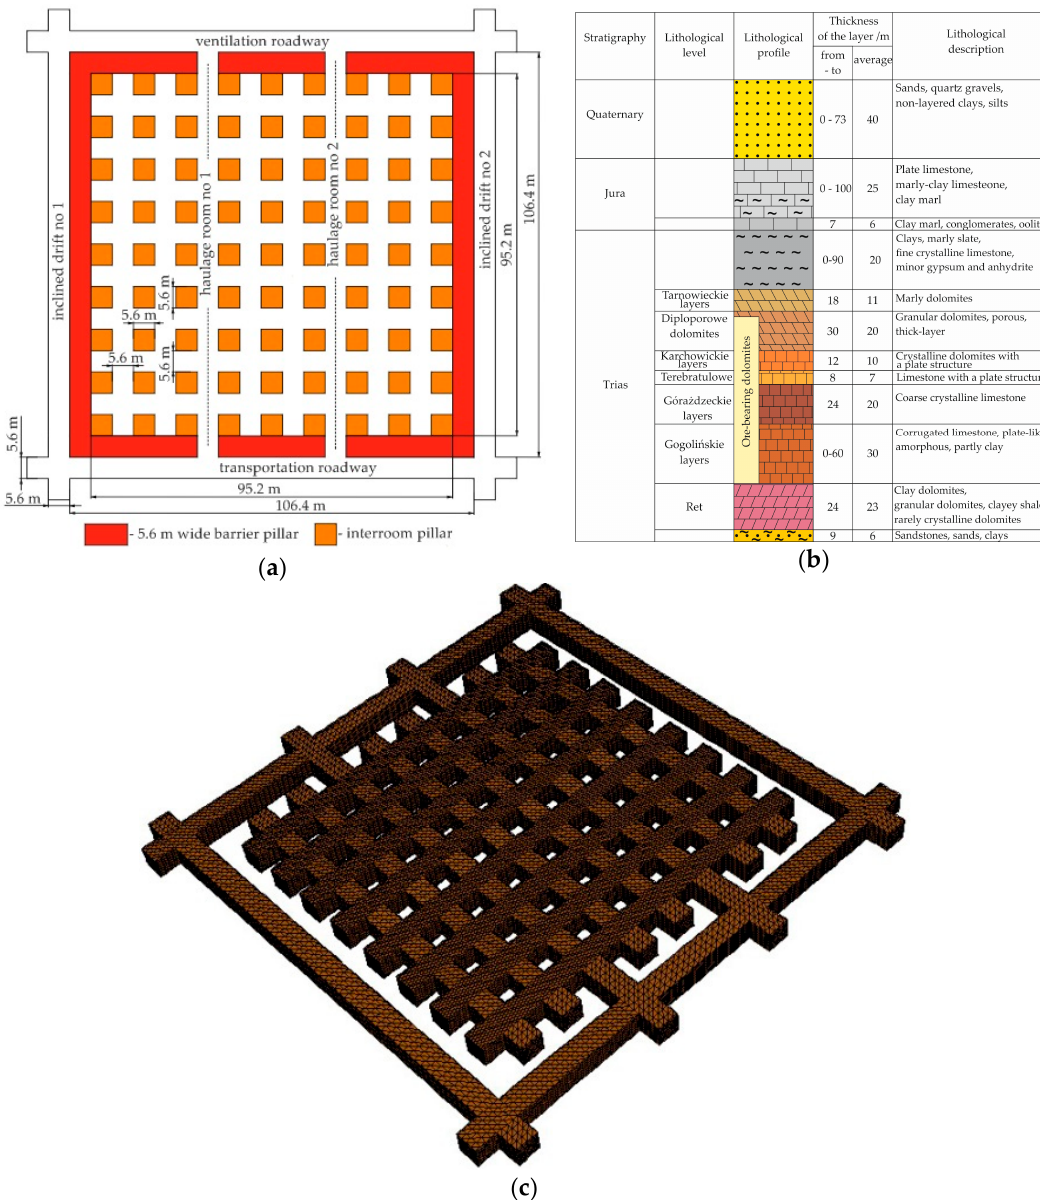
Figure 11. Mining and geological conditions in the Olkusz-Pomorzany area in Poland: ( a ) Design of the room and pillar method; ( b ) Lithological profile for the designed region; ( c ) Perspective view of the room and pillar method.